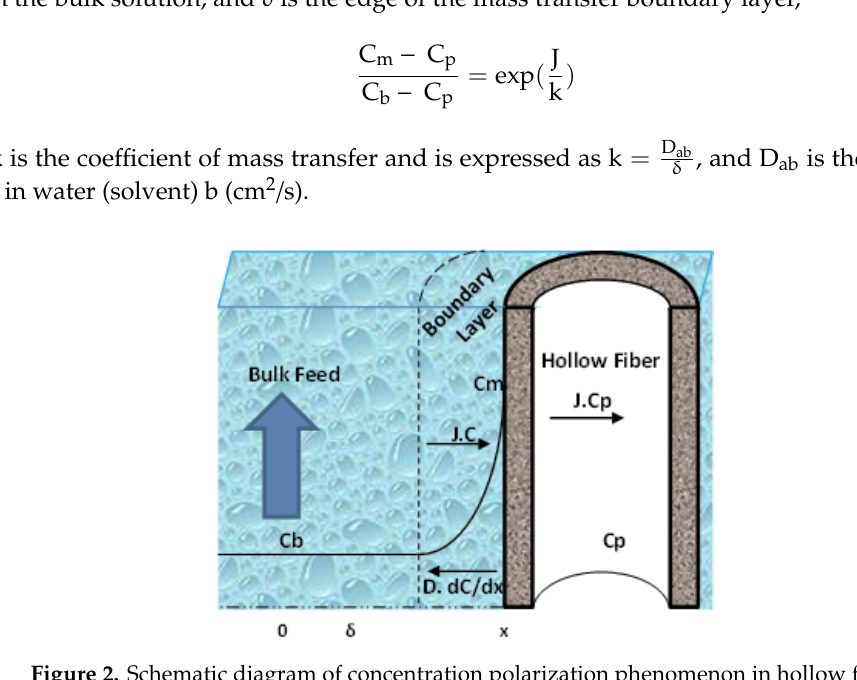
Figure 2. Schematic diagram of concentration polarization phenomenon in hollow fiber.